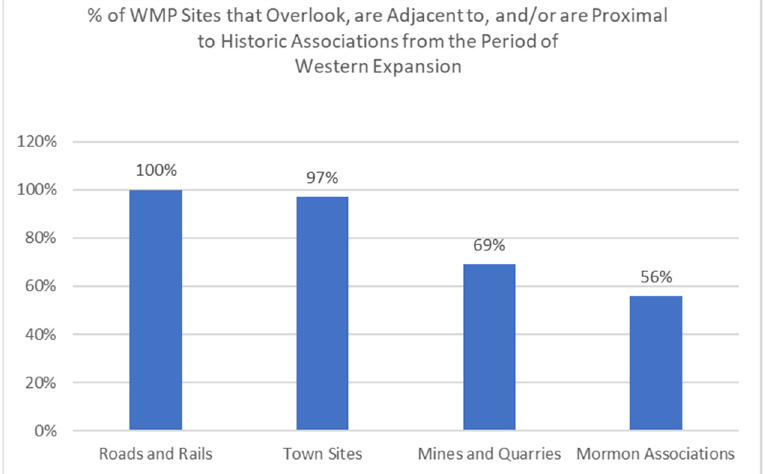
Figure 6. Western Message Petroglyph sites historic landscape contexts.